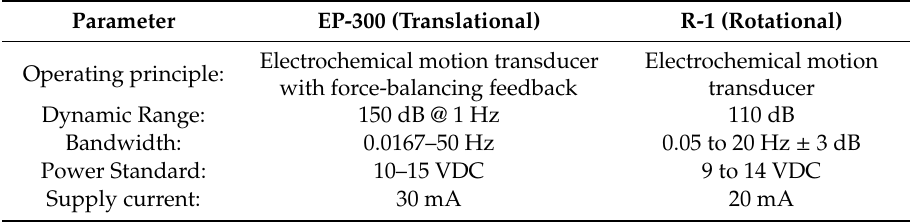
Table 1. Basic parameters of seismometers utilized for preliminary 6-DoF measurements. Parameter EP-300 (Translational) R-1 (Rotational) Electrochemical motion transducer Electrochemical motion Operating principle: with force-balancing feedback